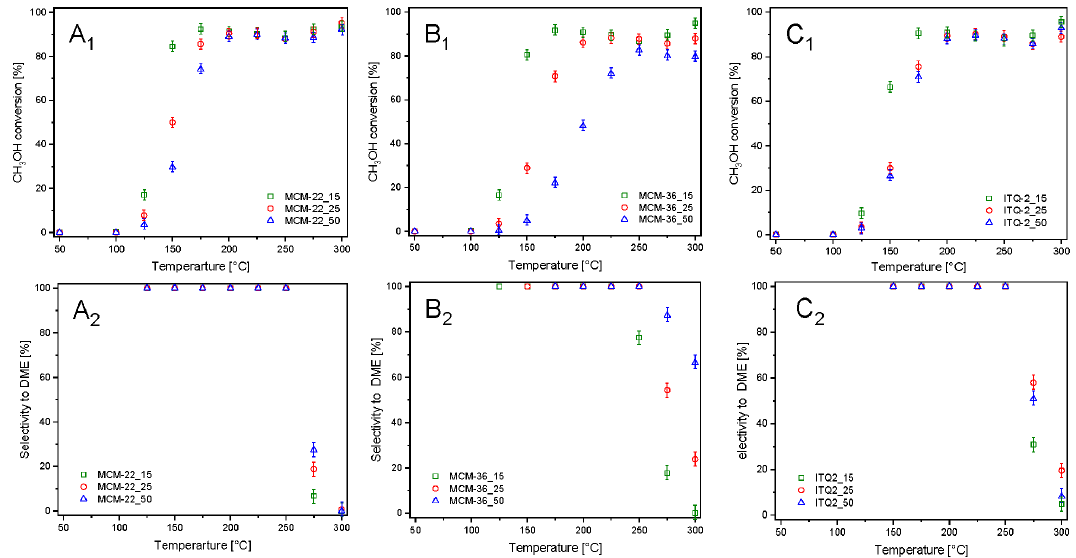
Figure 5. Results of catalytic dehydration of methanol in the presence of MCM-22 ( A 1 and A 2 ), MCM-36 ( B 1 and B 2 ), and ITQ-2 ( C 1 and C 2 ) zeolites.